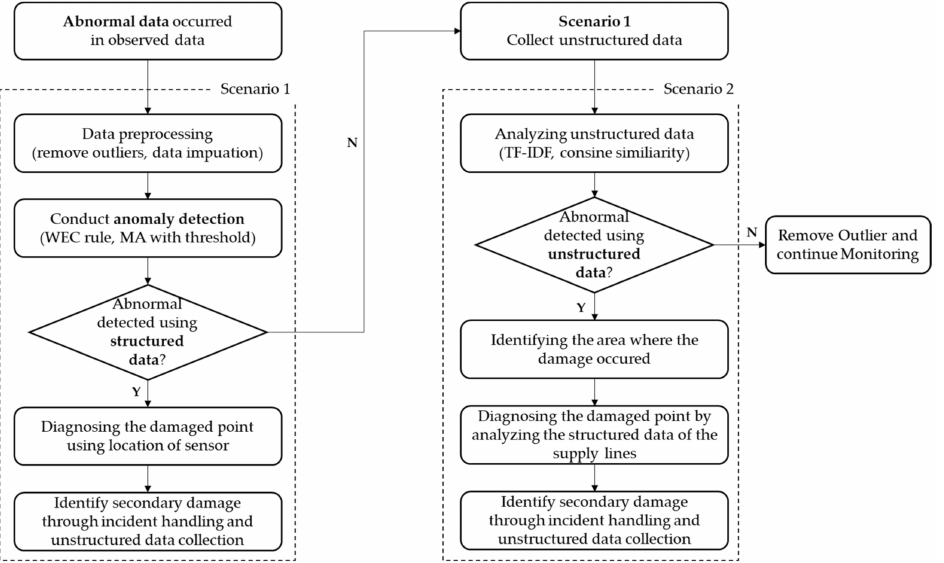
Figure 1. Water quality event detection and diagnosis framework using structured and unstructured